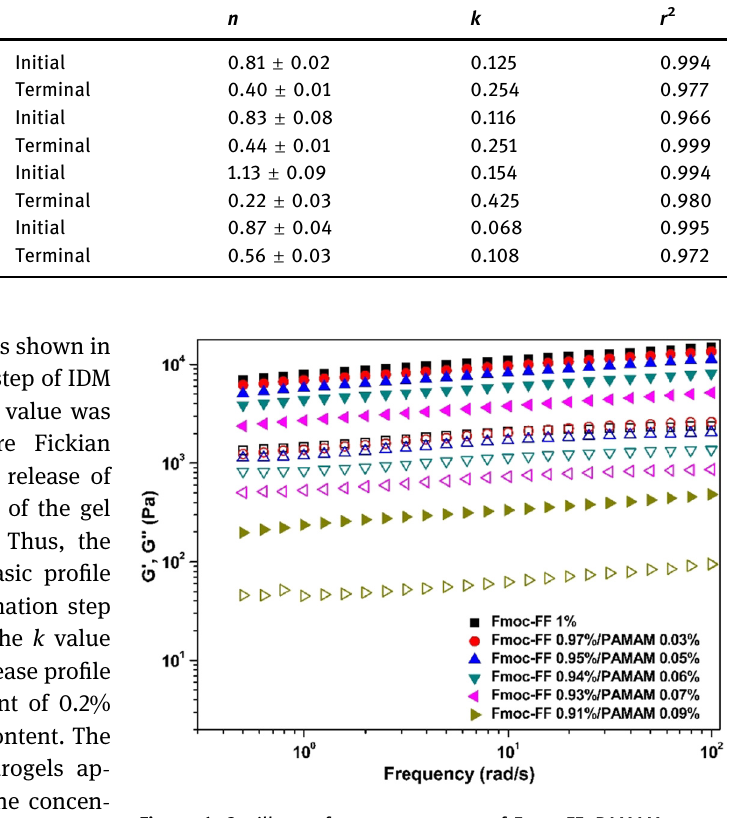
Figure 6: Oscillatory frequency sweeps of Fmoc - FF – PAMAM dendrimer hydrogels with di ff erent Fmoc - FF/PAMAM ratio: closed symbols denote G ′ and open symbols denote G ″